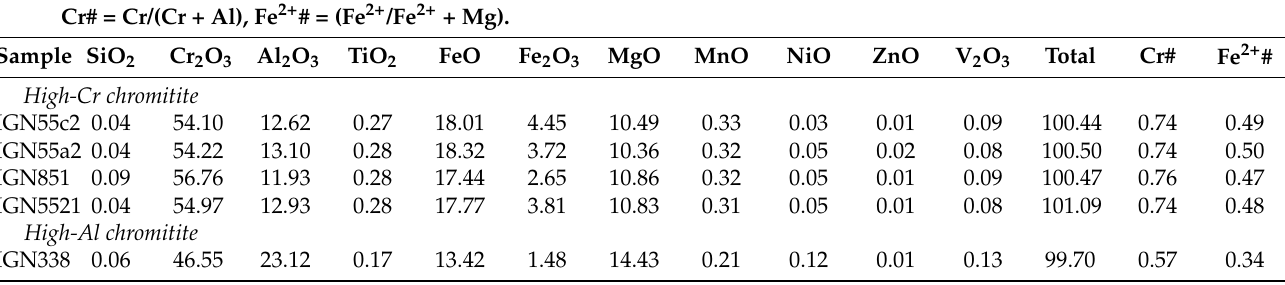
Table 1. Average composition of chromite based on 30 points analyses (wt%) in the High-Cr and High-Al Chromitite of Sebuku